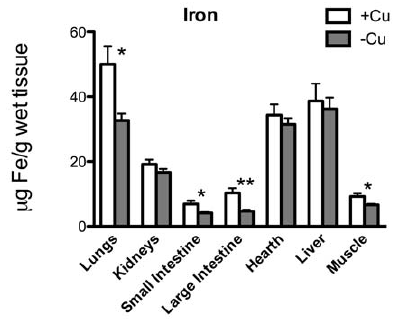
Figure 3. Fe content. Fe ( m g/g wet tissue) in the lungs, kidneys, small intestine, large intestine, heart, liver, and muscle. * p , 0.05; ** p , 0.01.